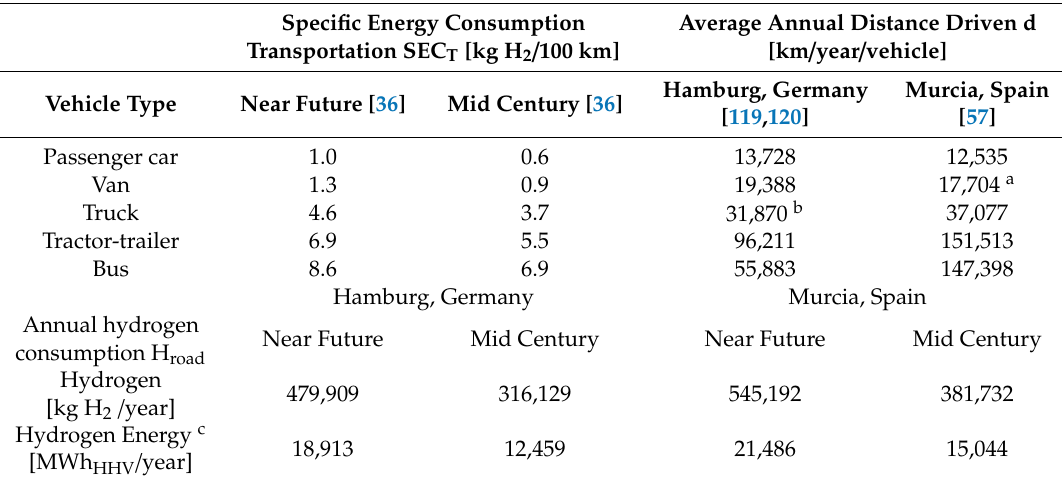
Table A6. The average annual distance driven d and Near Future and Mid Century scenario-specific energy consumption of transport (SEC T ) for van, truck, tractor-trailer, and bus type